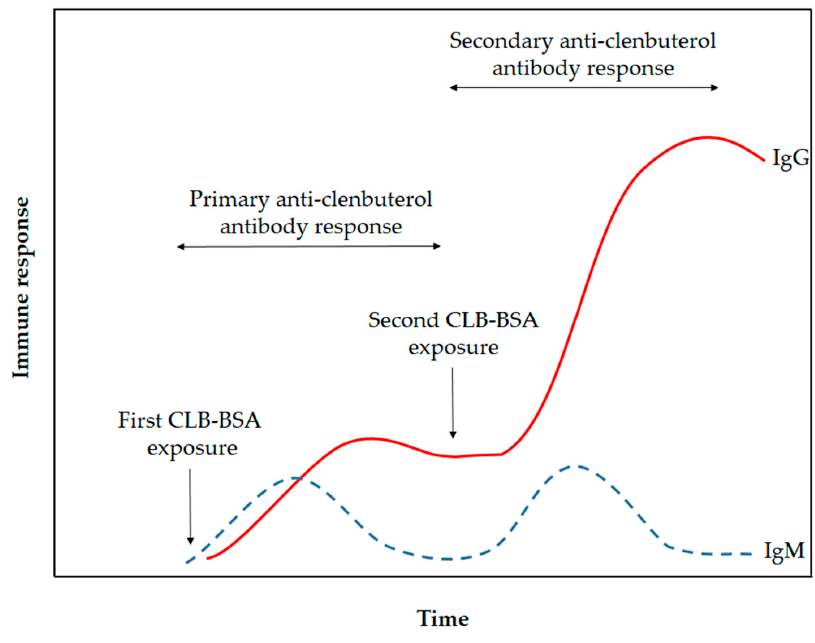
Figure 1. Schematic illustration of immune response towards exposure by CLB-BSA (adapted with modification from Coico et al. [22]).